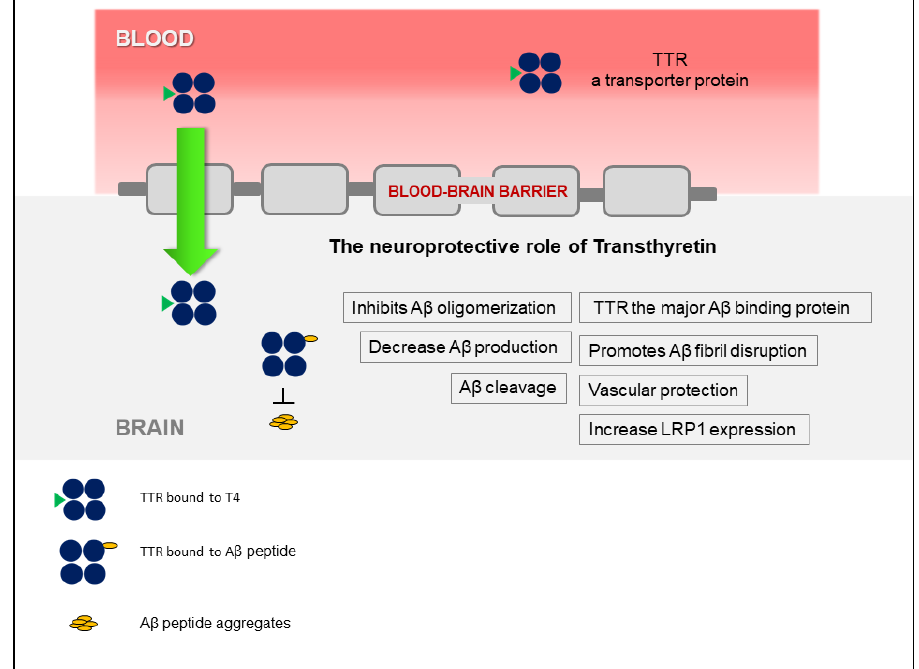
Figure 1. Schematic representation of the involvement of transthyretin (TTR) in neuroprotection in Alzheimer’s disease (AD), highlighting the different mechanisms involved.